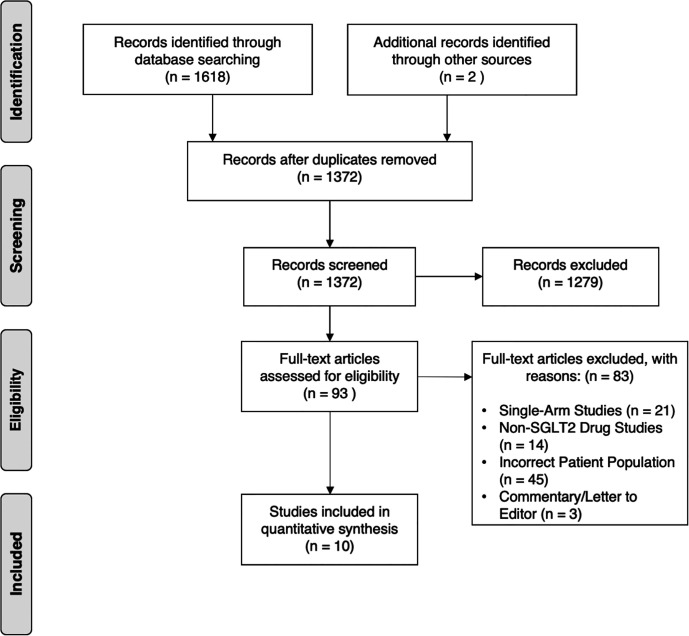
PRISMA Flow Diagram.